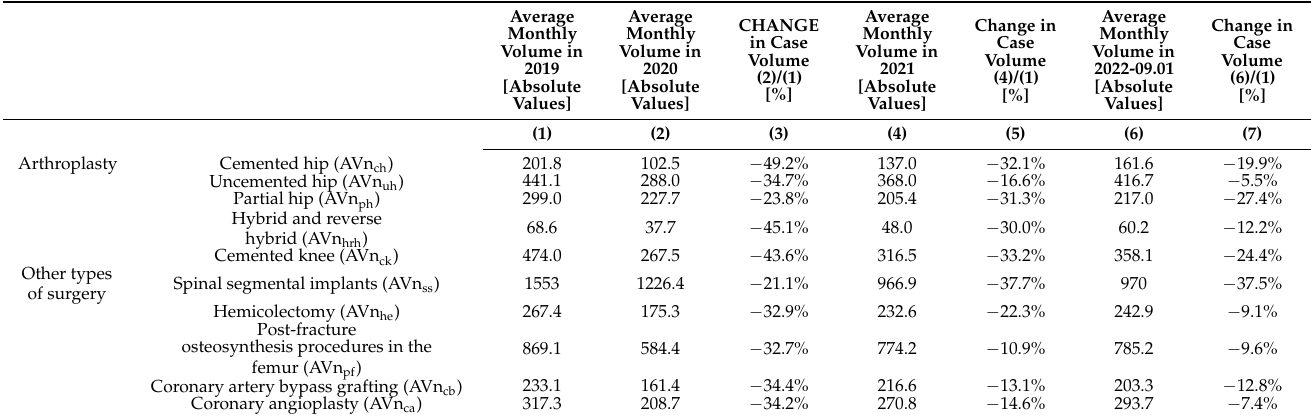
Table 6. Percentage change in average monthly case volume.